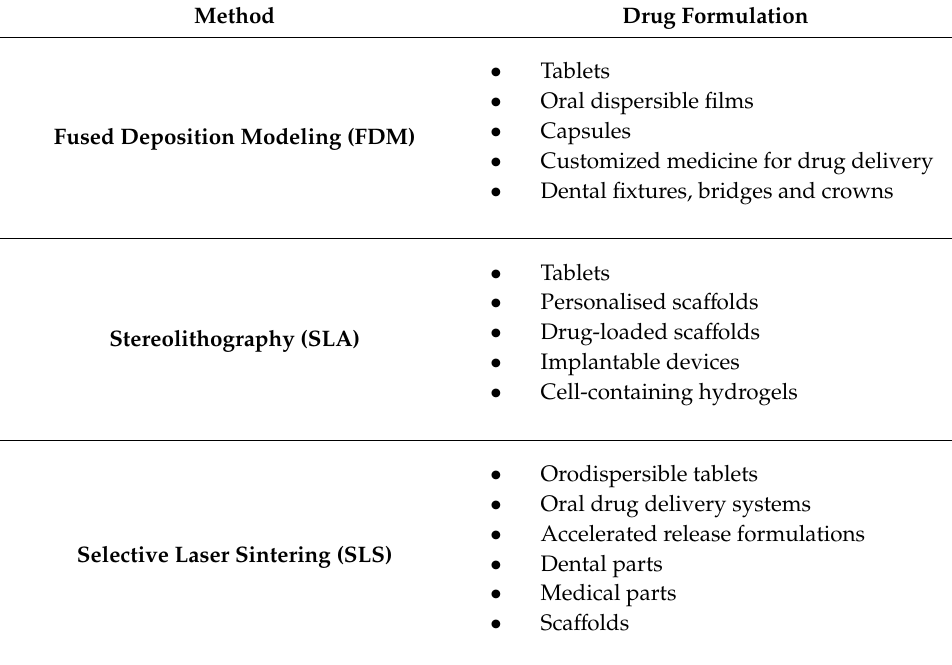
Table 2. Applications of 3D printing methods in the medical field